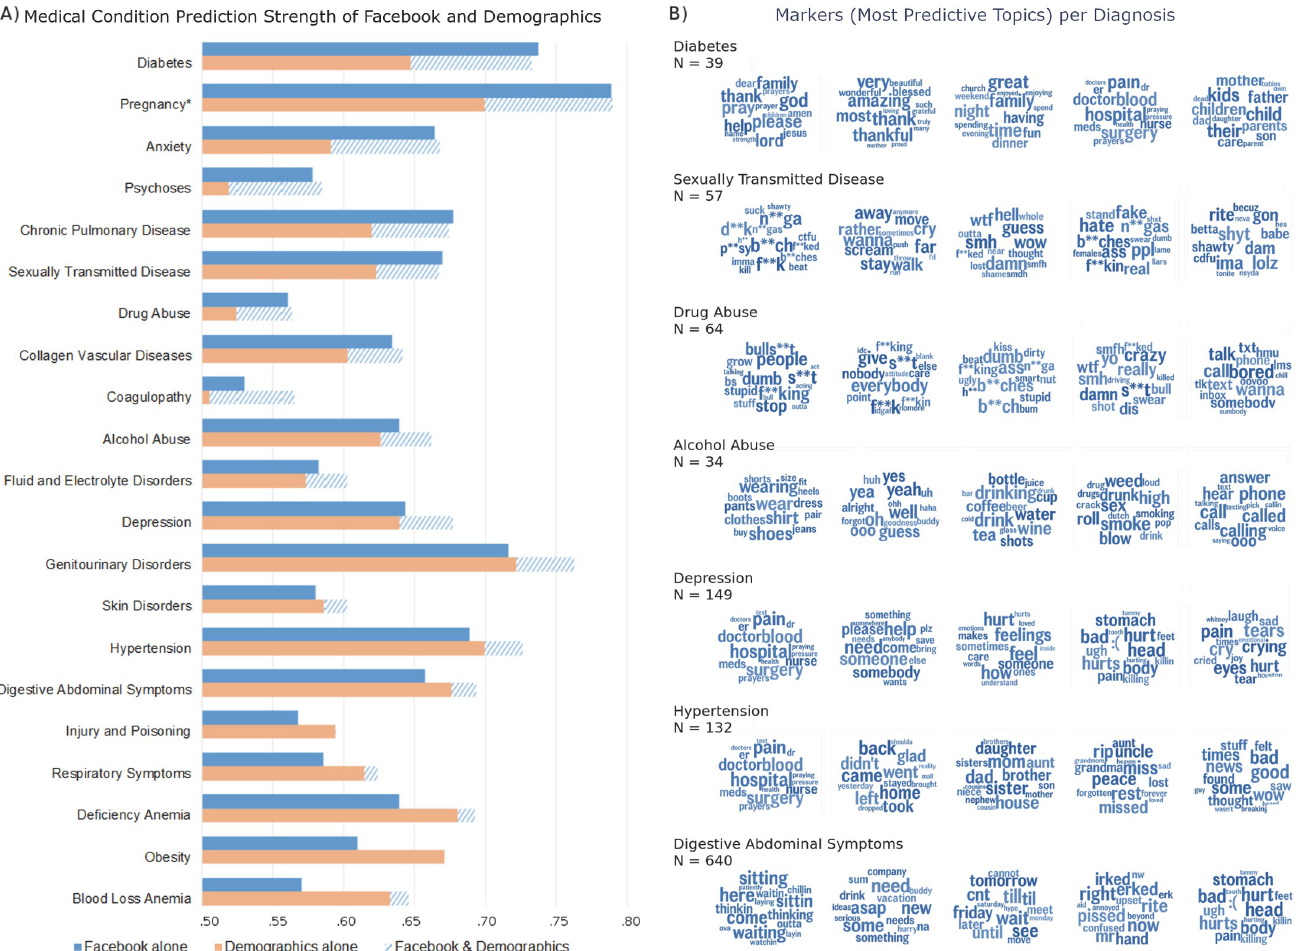
Fig 2. A. Diagnoses Prediction Strength of Demographics and Facebook. This figure represents overall accuracies of Facebook and demographic models at predicting diagnoses. Accuracies were measured using the area under the receiver operating characteristic curve (AUC), a measure of discrimination. The category “Facebook alone” represents predictions based only on Facebook language. “Demographics alone” represents predictions from age, sex, and race. “Demographics & Facebook” represents predictions based on a combination of demographics and Facebook posts. Diagnoses are ordered by the difference in AUC between Facebook alone and demographics alone. For the top 10 categories, Facebook predictions are significantly more accurate than those from demographics (p &lt; .05), and for the top 17 plus iron deficiency anemia, Facebook & demographics are significantly more accurate than Facebook alone (p &lt; .05). � Pregnancy analyses only included females. B. Markers (most predictive topics) per diagnosis. This figure illustrates top markers (clusters of similar words from social media language) most predictive of selected diagnoses categories. Word size within topic represents rank order prevalence in the topic. Expletives were edited and represented by stars (i.e. � ). All topics shown, except for those with digestive abdominal symptoms, were individually predictive beyond the demographics (multi-test correct p &lt; .05). (Full results in supplement [S2